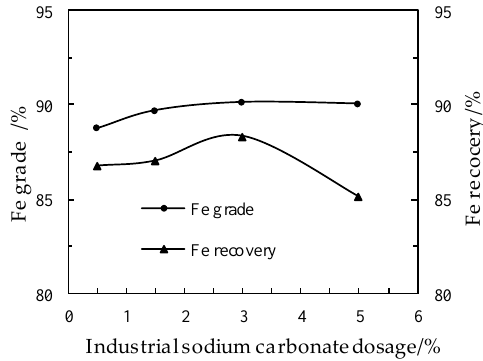
Figure 4. Effect of industrial sodium carbonate dosage on the DR process.